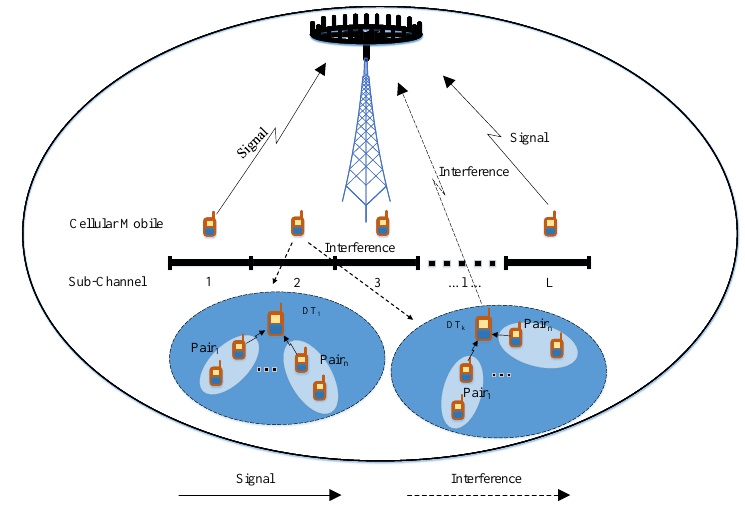
Figure 1. The considered system model in this